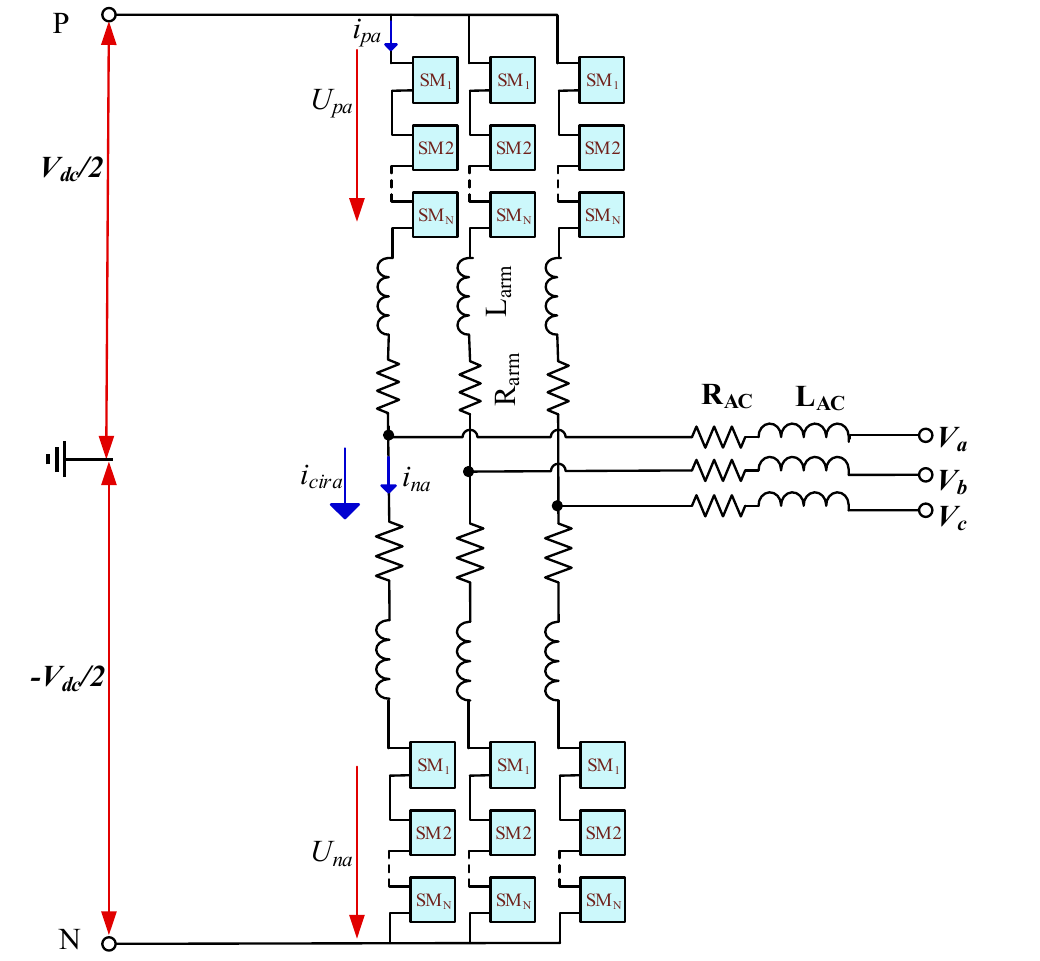
Figure 5. The circuit configuration of the MMC.